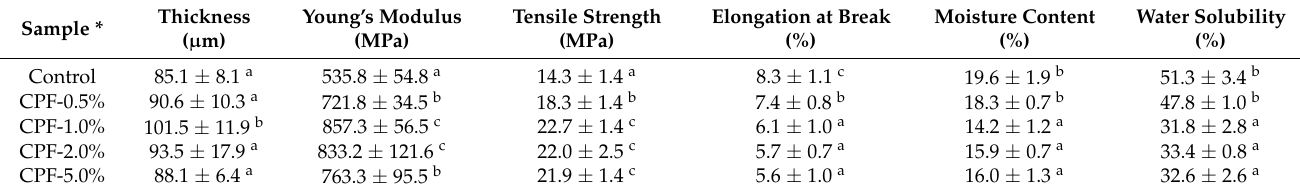
Table 1. Effect of CaCl 2 concentration on the mechanical properties of the crosslinked pectin films (CPF). Thickness Sample * ( µ